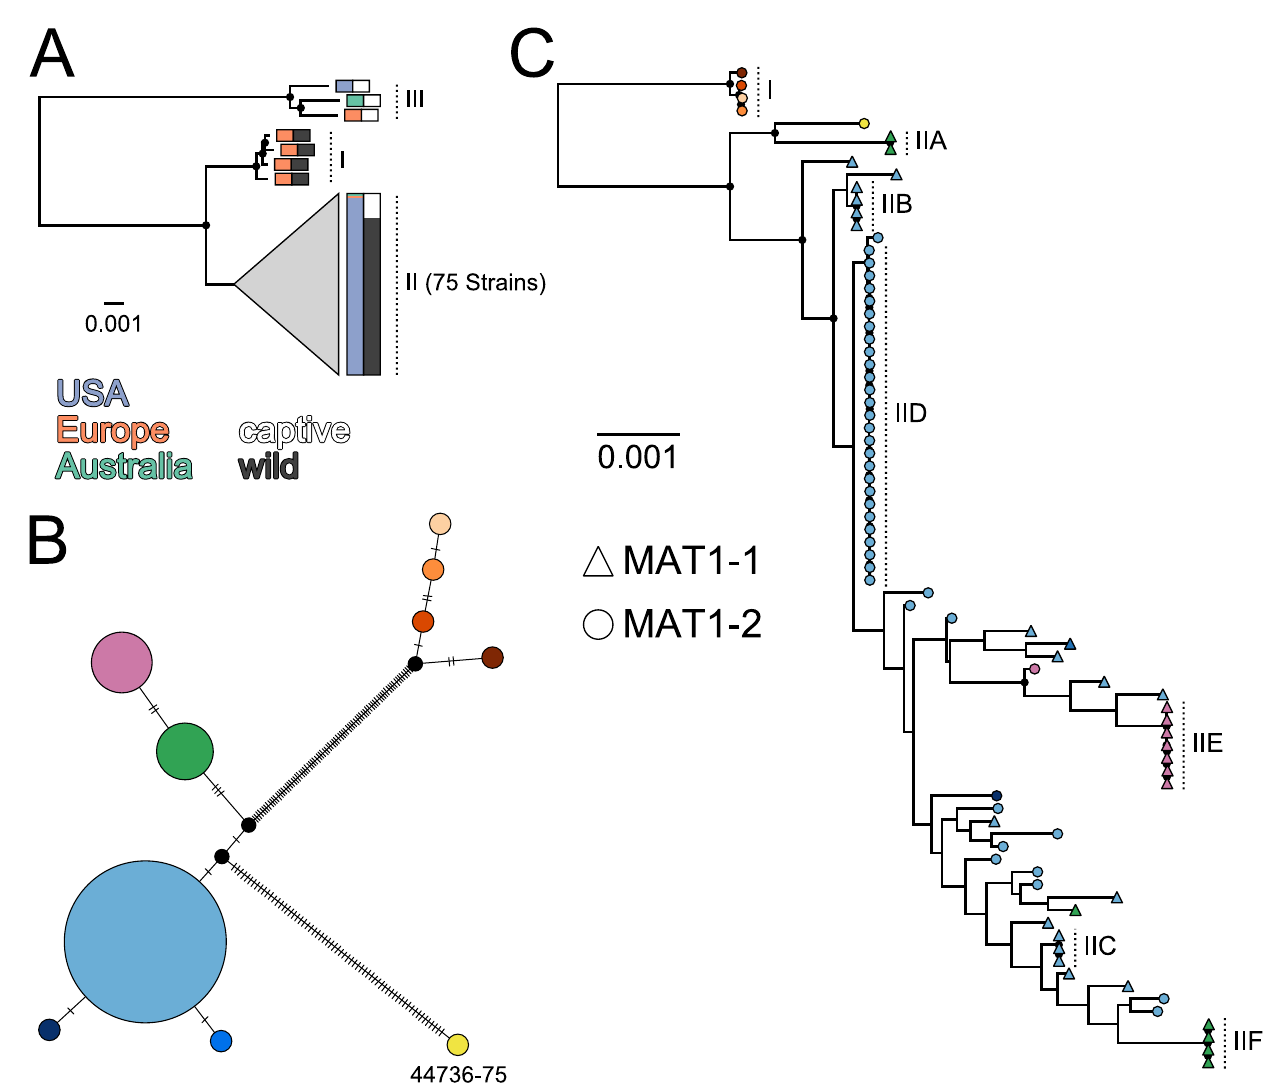
Fig 1. All North American isolates of Ophidiomyces ophiodiicola ( Oo ) form a well-supported clade, but there is discordance between genetic relationships within the nuclear and mitochondrial genomes. AU : AbbreviationlisthavebeencompiledforthoseusedinFigs 1 (cid:0) 4 : Pleaseverifythatallentriesarecorrect : ( A) Maximum-likelihood phylogeny including all 82 Oo strains and based on an amino acid- level alignment consisting of 5,811 nuclear proteins and 3,311,400 positions. Colors indicate the location from which the strain was obtained (blue, orange, and green) and whether the strain was isolated from a captive (white) or wild (black) snake. Clade II, which contains 75 strains, has been collapsed and the colored bars to the right of this clade indicate the proportion of strains from each category. See S1 Fig for an uncollapsed version of this tree. (B) A median-joining haplotype network including all 79 strains from Clades I and II and built from 159 SNPs present in the mitochondrial genome (“best” SNPs from NASP). Haplotype colors correspond to the tip colors from (C). Each tick mark corresponds to a single SNP difference and black circles represent inferred, but unsampled nodes. (C) Maximum-likelihood phylogeny including all 79 strains from Clades I and II and based on an alignment of 19,699,744 base pairs, including 189,199 SNPs from the nuclear genome. Tip shapes indicate the mating type of each strain, and colors correspond to the mitochondrial genotypes presented in (B). Vertical dotted lines and labels indicate the strains of Clade I, as well as the putative clonal lineages within Clade II. In both (A) and (C), filled black circles indicate nodes with bootstrap support � 90 and the scale bar represents the horizontal length equivalent to 0.001 changes per site. Data underlying this figure can be found in OSF: https://osf.io/fmbh5/. SNP, single nucleotide